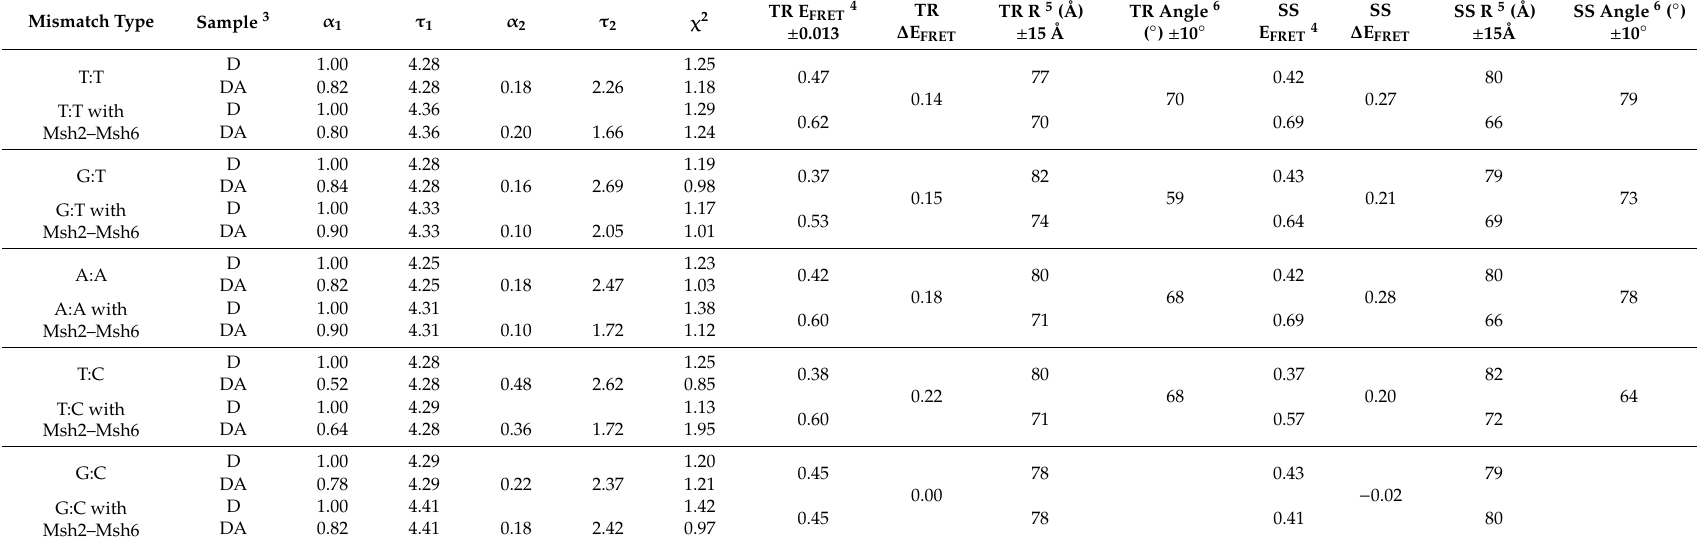
Table 2. Steady-state (SS) and time-resolved 1 (TR) Förster Resonance Energy Transfer Measurement Parameters 2 . Mismatch